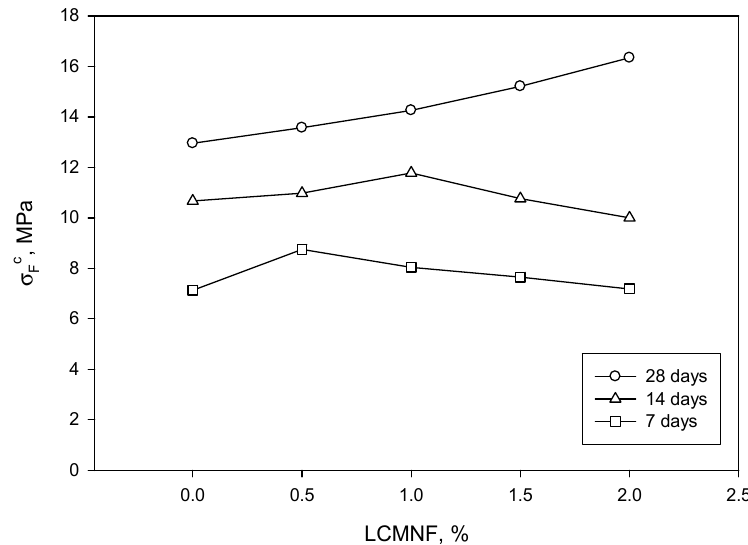
Figure 3. Evolution of flexural strength of the resulting cement-based composites after 7, 14, and 28 days of material curing. Materials 2019 , 12 , x FOR PEER REVIEW